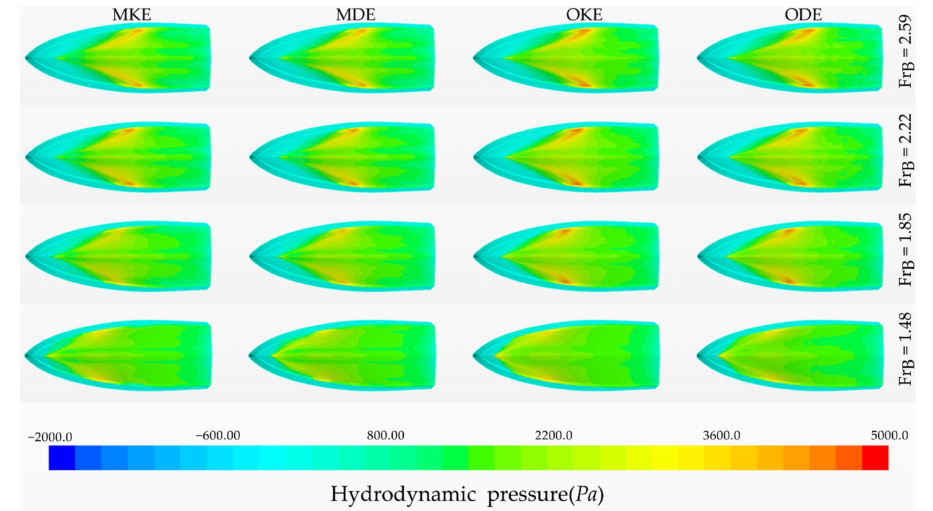
Figure 11. Hydrodynamic pressure distribution on the bottom of the planing vessel, found using different CFD models, at different beam Froude Numbers.